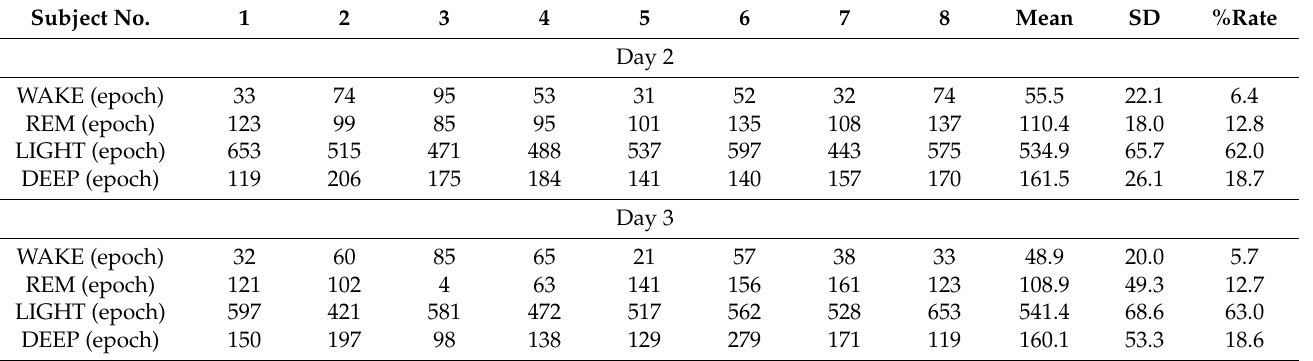
Table 4. Results of sleep stages used as correct data.